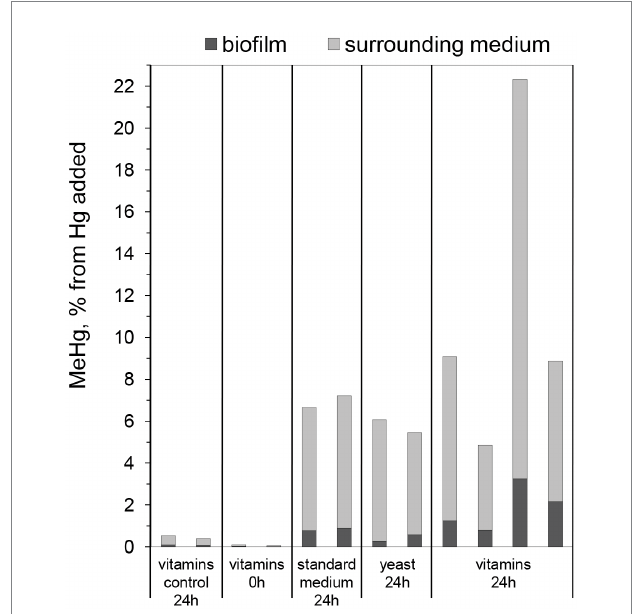
FIGURE 1 Percentage of MeHg produced from 100 nM added Hg, determined in biofilms and surrounding media, after 0 or 24 h of incubation with Geobacter sulfurreducens biofilms grown for 7 days in standard nutritive medium (“standard medium”), in standard nutritive medium amended with yeast extract (“yeast”), or standard nutritive medium amended with vitamins mixture (“vitamins”). Control represents samples without Hg addition. Bars represent MeHg produced of which the gray part represent MeHg in the surrounding medium and the black part MeHg in the biofilm. Each bar represents one experimental